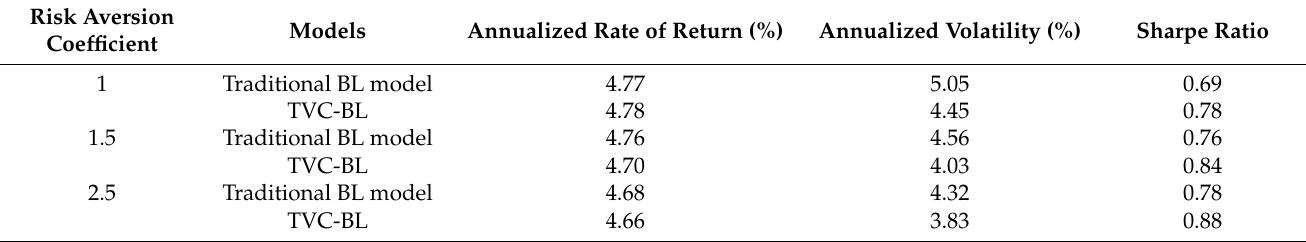
Table 4. The annualized rate of return and annualized volatility of the proposed model and the models for comparison.